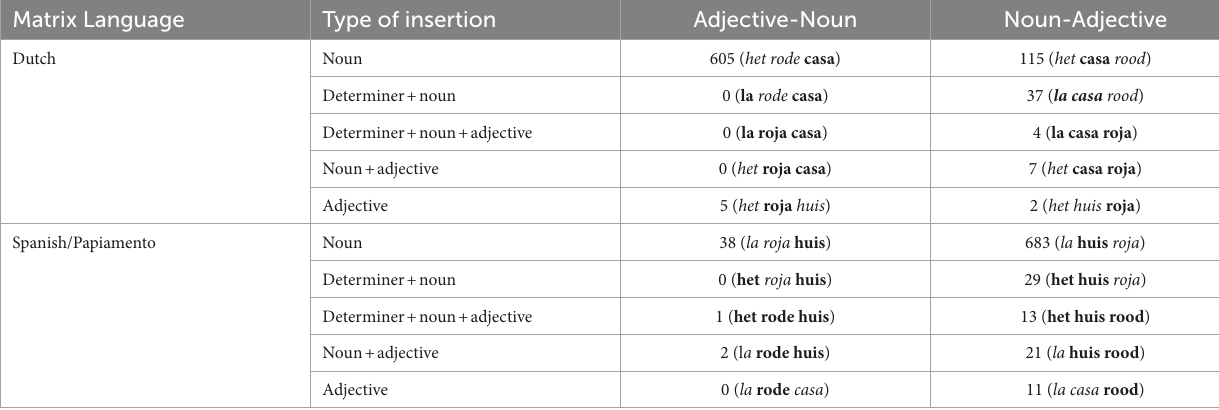
TABLE 5 Production of word order by matrix language and type of insertion. Matrix